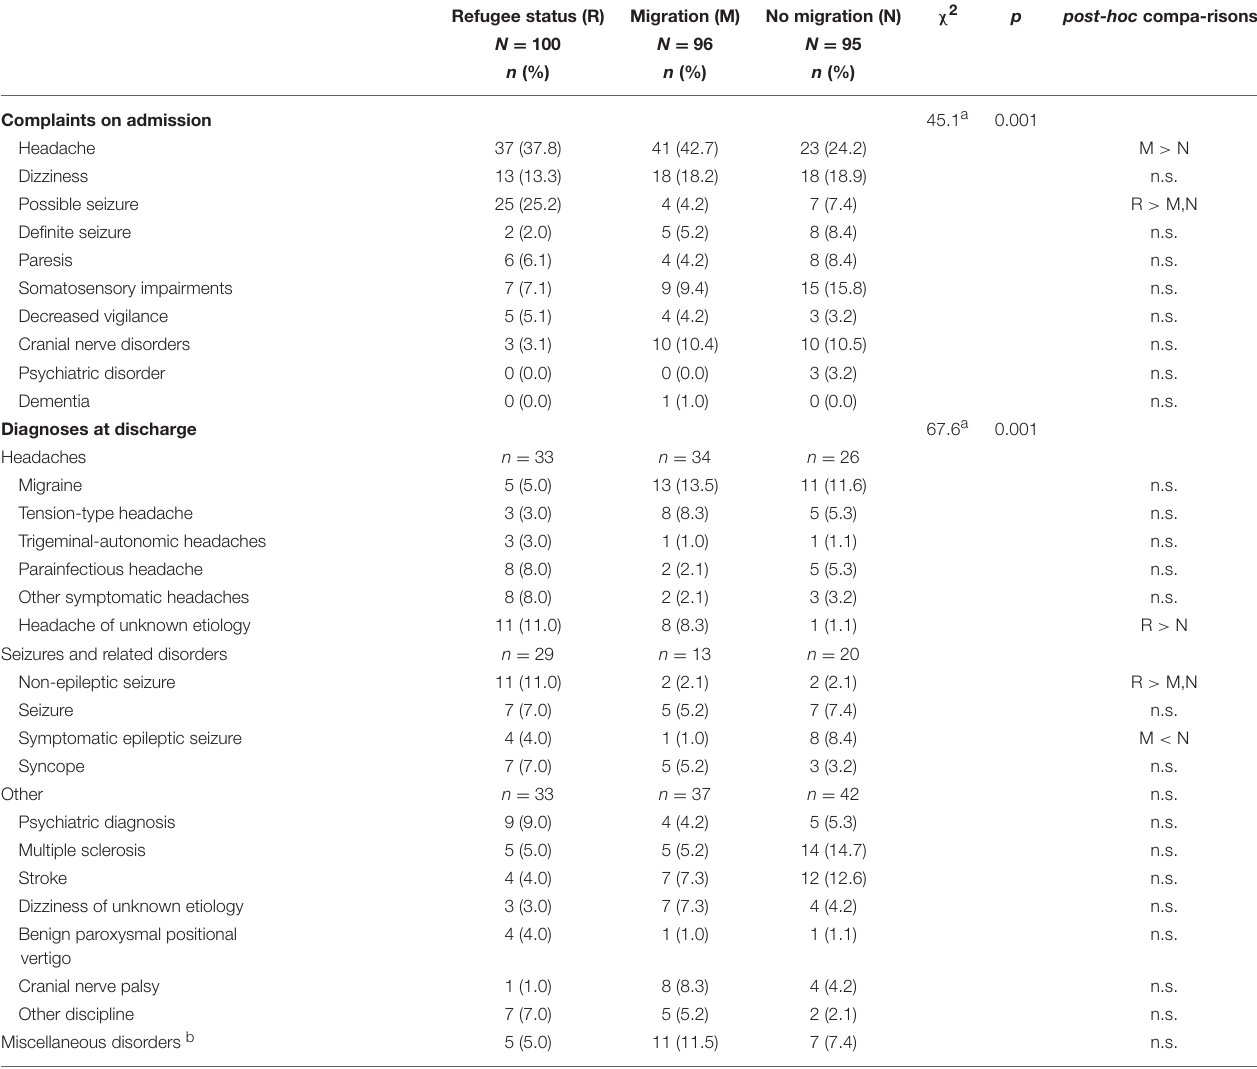
TABLE 2 | Neurological complaints on admission and diagnoses at